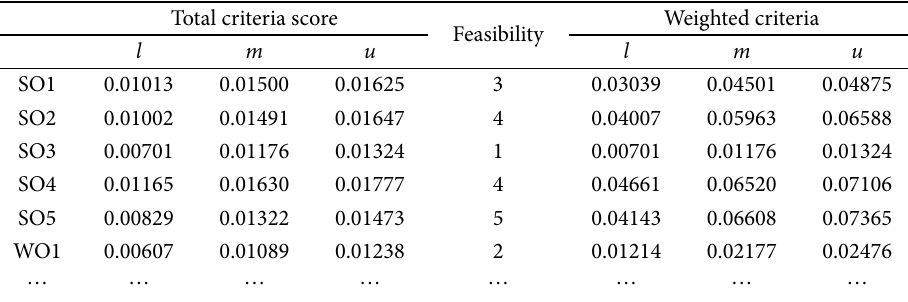
Table 6. Total criteria score, feasibility degree and weighted criteria Total criteria score